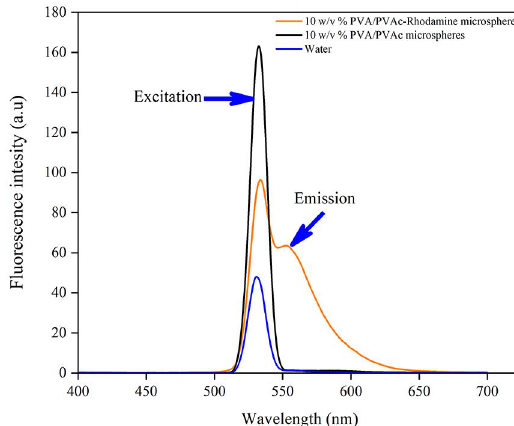
Figure 12. Excitation (530 nm) and Fluorescence response (553 nm) of water (C), PVA/PVAc microspheres (A) and PVA/PVAc -Rhodamine microspheres dissolved in ethanol (B).